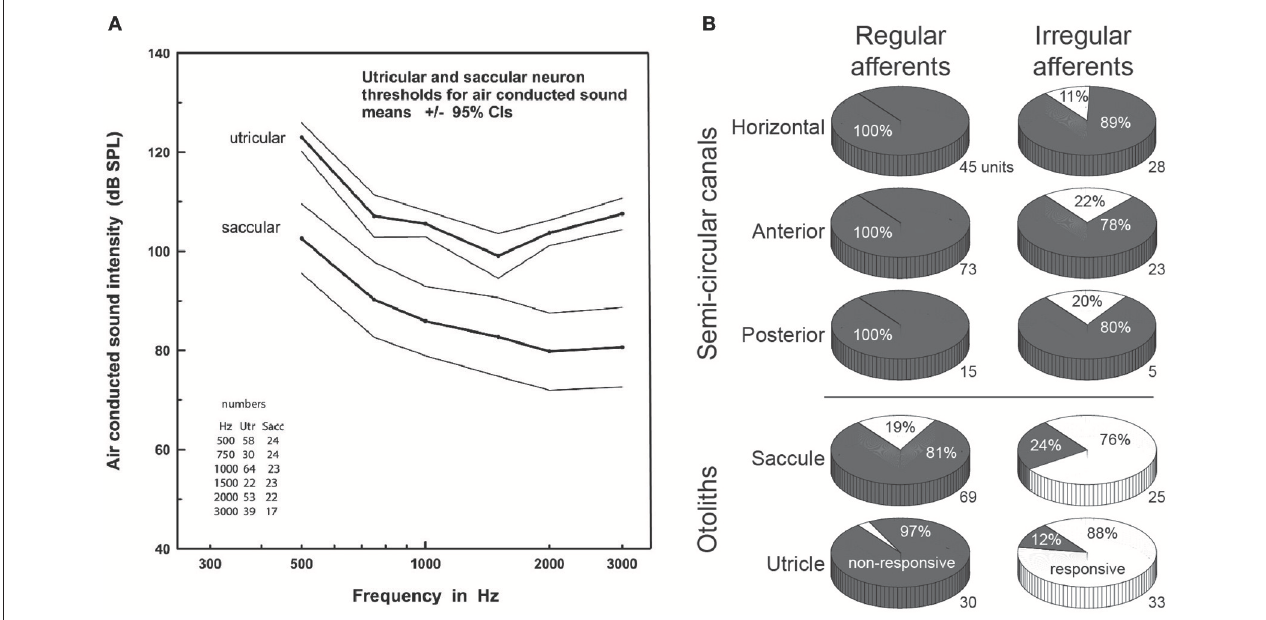
FIGURE 1 | (A) Response thresholds for utricular vs. saccular afferents to various frequencies of air-conducted sound. Note the lower thresholds for saccular vs. utricular afferents. Reproduced from Curthoys et al. ( 20), with permission from Elsevier. (B) Comparative response proportions for regular and irregular afferents from the various vestibular end-organs to bone-conducted vibration in the guinea pig, expressed as a percentage of responsive vs. non-responsive afferents (the number to the bottom-right of each pie chart shows the sample size. Note the greater responsivity for otolith vs. canal afferents, and for irregular vs. regular afferents. Data taken from a table presented in Curthoys et al. (20), with permission from Springer